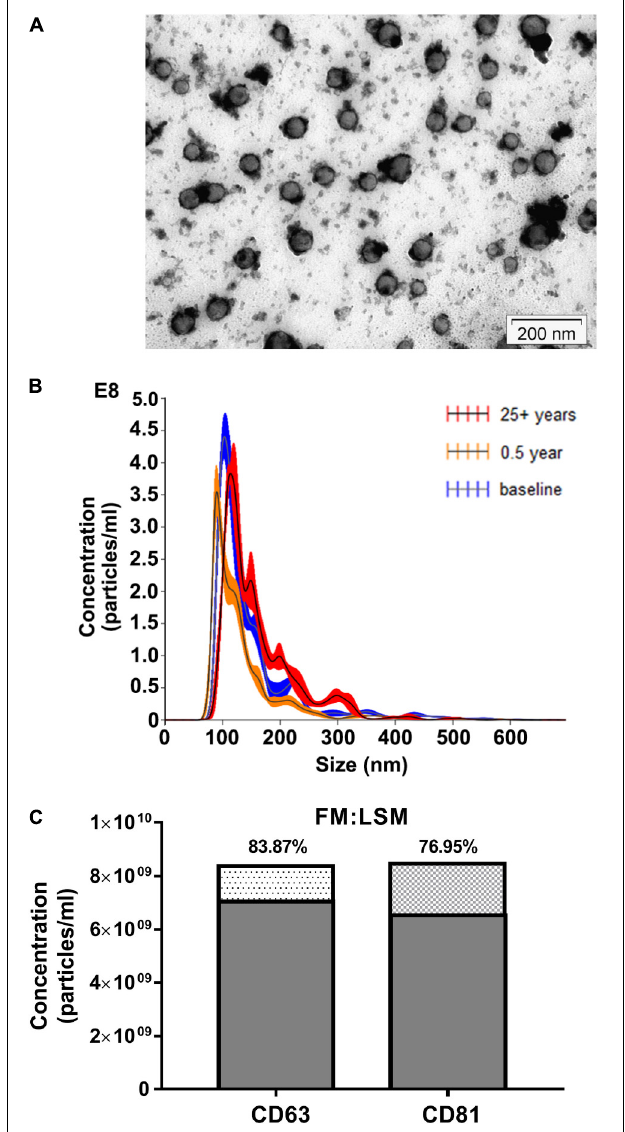
FIGURE 2 | Characterization of exosome-enriched preparations isolated from human serum. (A) Transmission electron microscope (TEM) image of exosomes purified from human serum samples (Scale bar: 200 nm). (B) Analysis of EV size distribution and concentration in exosome-enriched preparations using a NanoSight NS300 instrument. (C) Evaluation of CD63 and CD81 surface expression abundance in exosome-enriched preparations using a NanoSight NS300